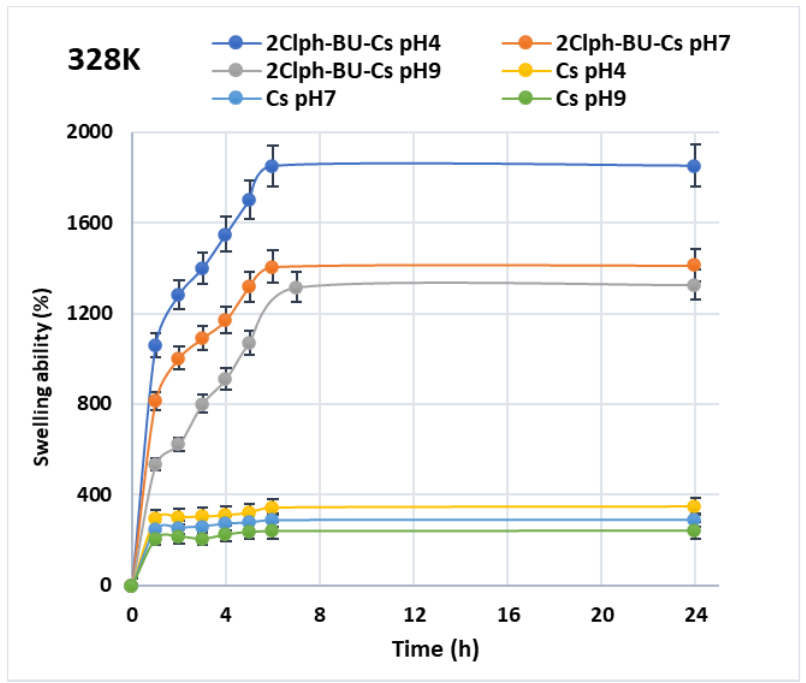
Figure 9. Swelling ability of Cs and 2Clph-BU-Cs hydrogel in pH 4, 7, and 9 at T= 328 K.